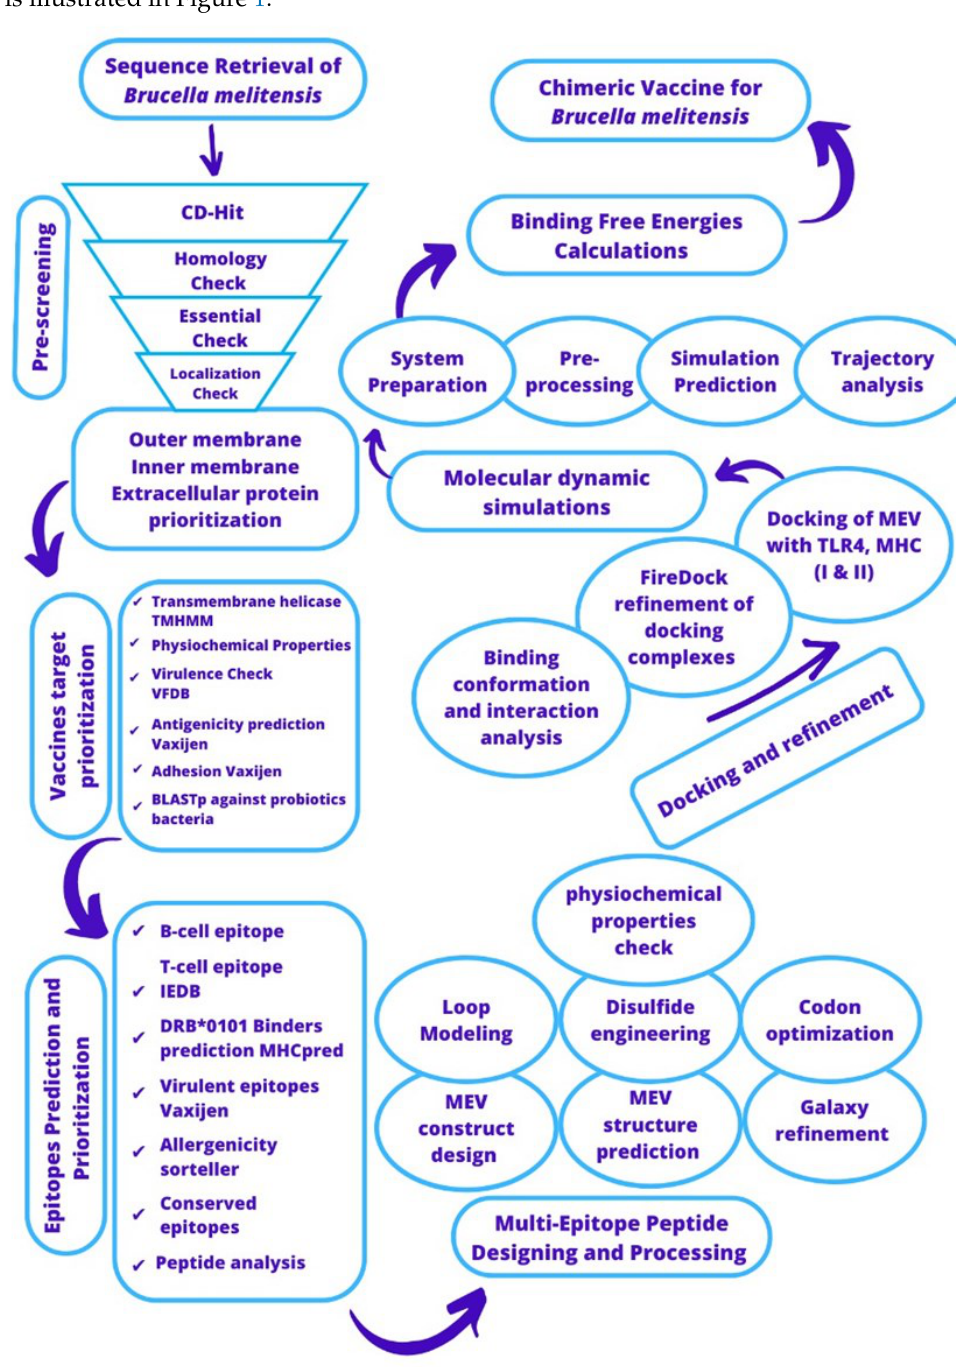
Figure 1. Outline of methodology that was used for designing a multi-epitopes vaccine against B. melitensis